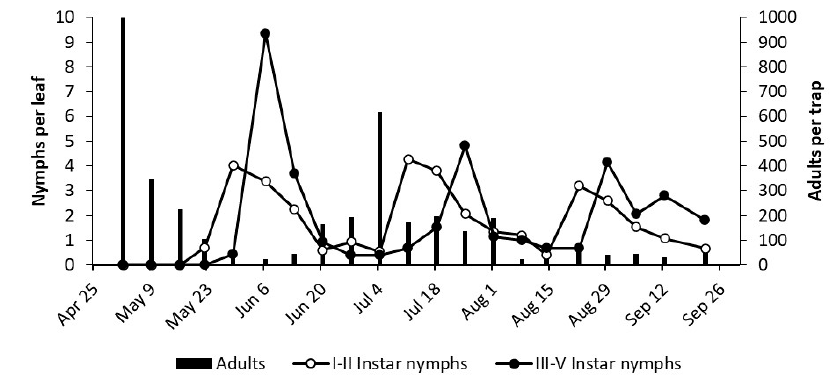
Figure 5. The phenology of E. vulnerata in AC vineyard in the growing season of 2017.